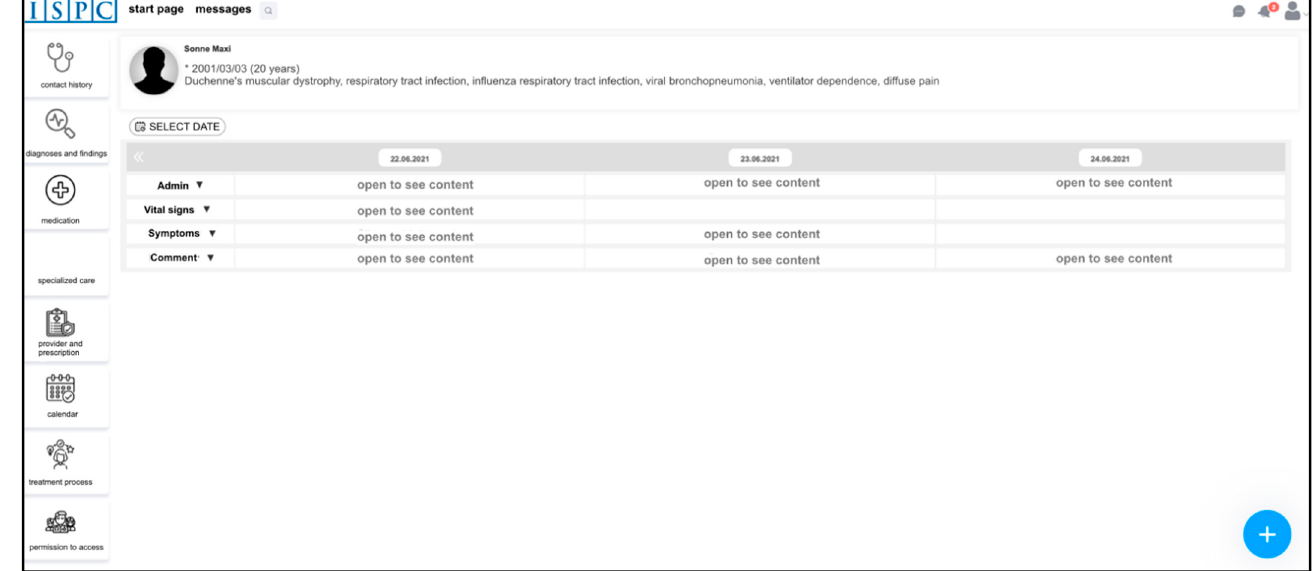
Figure 2. Screenshot from the patient-related menu and contact history (translated).